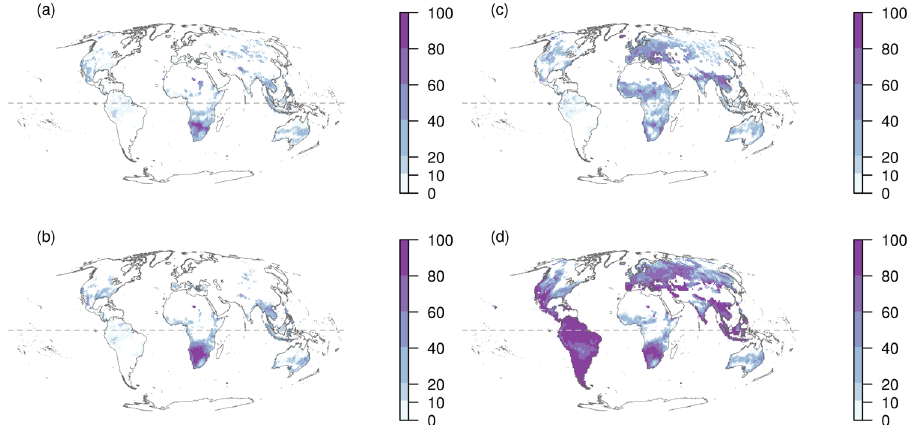
Fig. 2 Geographical patterns of percentage of amphibian species loss. Geographical patterns of percentage of amphibian species loss under a full dispersal scenario across six biogeographical regions (Afrotropical, Australasian, Indomalaya, Nearctic, Neotropical, and Palearctic) for different climate change scenarios. Panels a and b correspond to mapping of the percentage of species loss per pixel (1°) under a high-warming scenario (RCP8.5) for 2030 and 2070, respectively. Panels c and d correspond to mapping of the percentage of species loss under the hosing experiment D (0.68-Sv; 1 Sv = 10 6 m 3 /s) for 2030 and 2070, respectively. The geographical patterns were calculated averaging the results from three niche modeling algorithm (Maxent, BRT, CART) to account for model uncertainty explicitly in the mapping of species loss across the